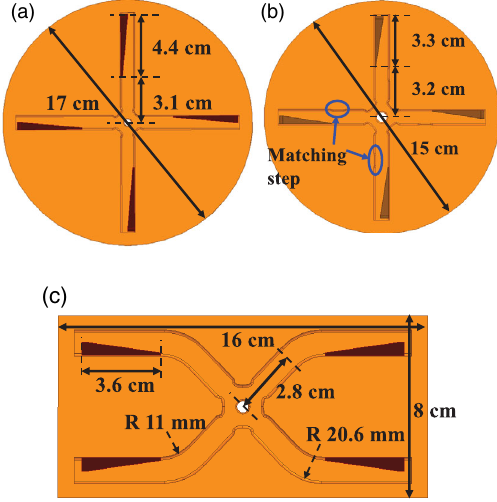
FIG. 21. Three designs of damping loads for new CLIC-G structure: (a) regular waveguides; (b) waveguides with matching step; (c) bended waveguides.